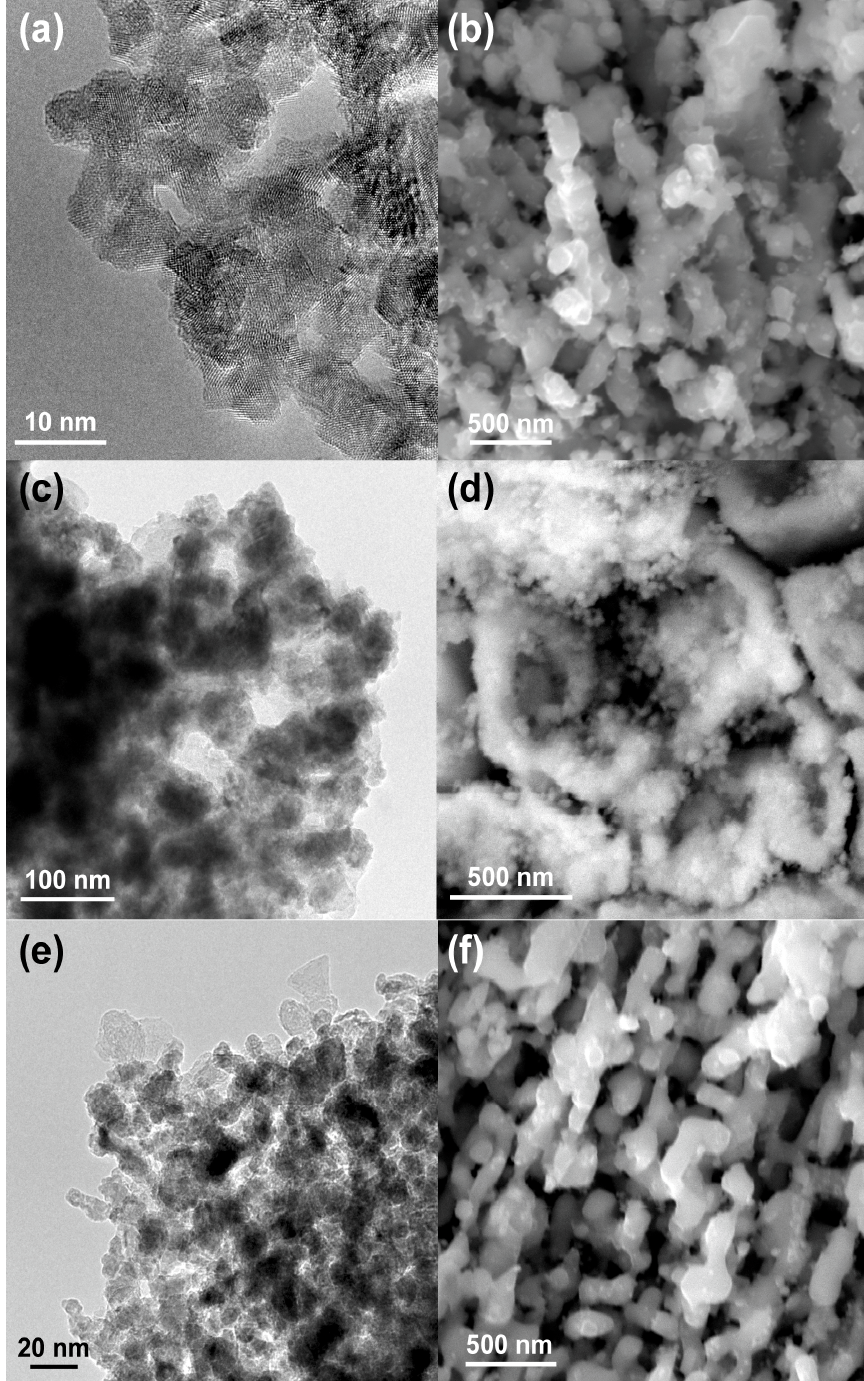
Figure 2. Microstructure observations taken by SEM or TEM before ( a , c , e ) and after ( b , d , f ) the catalysis tests; ( a , b ) NP ‐ Ni; ( c , d ) NP ‐ Co; and ( e , f ) NP ‐ NiCo.